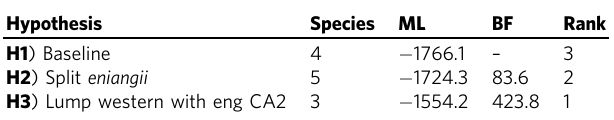
Table 1 Comparison of 3 gecko species boundary hypotheses using BFD* (with a Yule tree prior) and the 129 SNP dataset 4